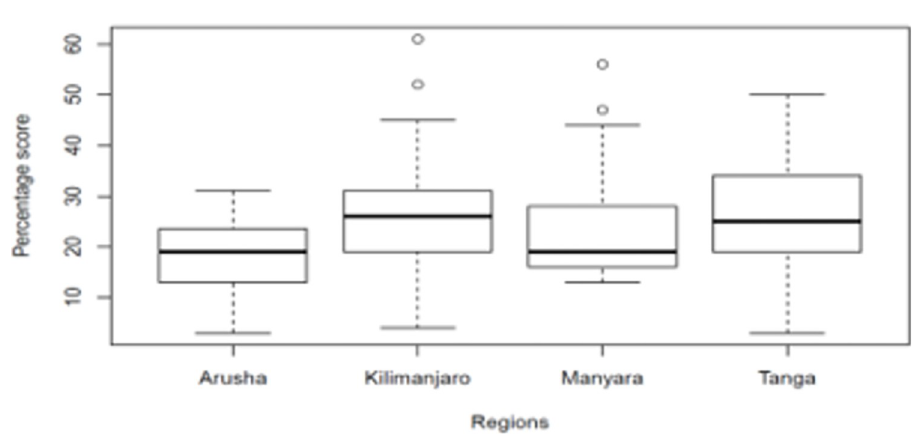
Fig 6. Boxplot of mean pulmonary NTM awareness scores per